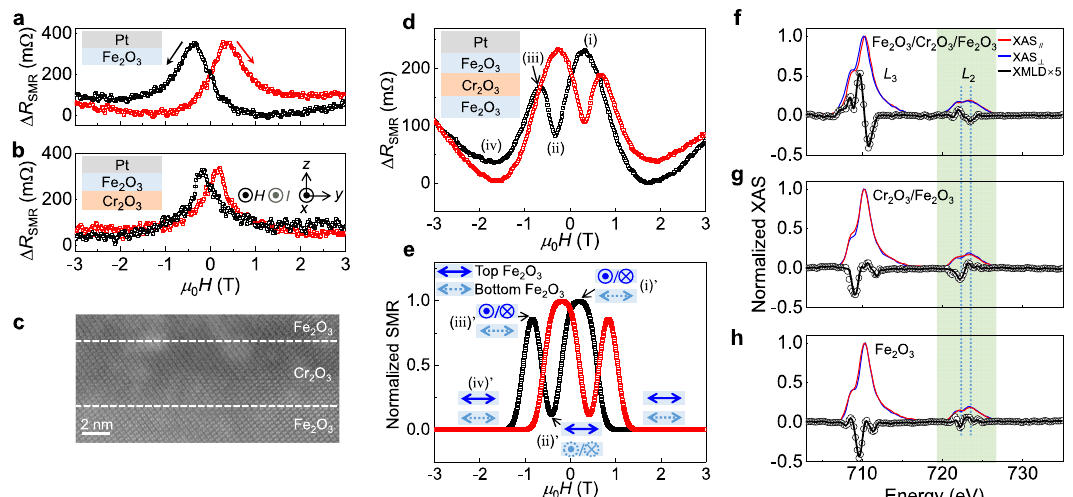
Fig. 2 SMR and XMLD results of antiferromagnetic junctions. a , b Magnetic fi eld dependent SMR curves in control samples Fe 2 O 3 /Pt ( a ) and Cr 2 O 3 / Fe 2 O 3 /Pt ( b ) at 300 K. Δ R SMR denotes the difference between resistance and the minimum one. Inserts are experimental set-up. c HAADF-STEM image of the Fe 2 O 3 /Cr 2 O 3 /Fe 2 O 3 junction. d SMR signals of Fe 2 O 3 /Cr 2 O 3 /Fe 2 O 3 /Pt samples at 300 K. e Simulated SMR curve of Fe 2 O 3 /Cr 2 O 3 /Fe 2 O 3 /Pt samples at 300 K. Inserts are diagram of magnetic con fi gurations at typical magnetic fi elds. f – h Normalized XAS and XMLD spectra of Fe 2 O 3 /Cr 2 O 3 /Fe 2 O 3 ( f ), Cr 2 O 3 /Fe 2 O 3 ( g ) and Fe 2 O 3 ( h ) samples. The XMLD spectra were taken from the differences of XAS spectra (XAS ⊥ – XAS // ) and then multiply by a factor of 5 at the absorption edges for clarity. The highlighted region denotes Fe- L 2 edge and the vertical dotted lines are guidance for eyes to mark the valleys and peaks in XMLD y -axis ( ⊥ ), respectively. Corresponding data are presented in Fig. 2f, where L 2 -edge is highlighted because it is generally used for analyzing Fe-based XMLD spectra 34,35 . Remarkably, Fe L 2 - Fig. 2e]. In this case, the spin current is re fl ected at the interface edge XMLD spectrum exhibits a zero – positive – negative – zero feature, which is quite a characteristic for the n along the parallel direction ( n // x -axis) 34,35 , rather than the spin- fl op direction ( y - axis). The n (top Fe 2 O 3 ) aligned along H con fi rms the interlayer coupling, which is also corroborated by a series of XMLD measurements with sample rotation (Supplementary Note 9). In control samples Fe 2 O 3 and Cr 2 O 3 /Fe 2 O 3 , where identical experiments were carried out, the scenarios differ dramatically. An opposite polarity at L 2 -edge (Fig. 2g, h, respectively), namely zero – negative – positive – zero, was observed, suggesting that the n in Fe 2 O 3 is mainly aligned along the spin- fl op direction ( n // y - axis) without interlayer coupling.